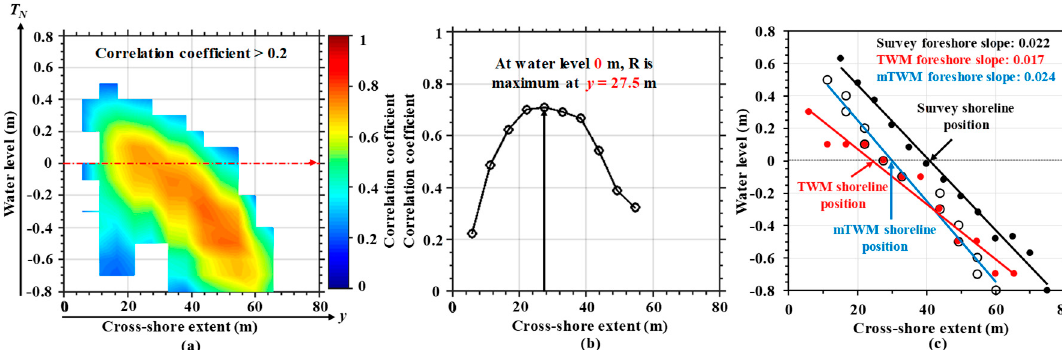
Figure 10. An example of a modified Temporal Waterline Method (mTWM) detected intertidal beach profile at x = − 49 m during 17–30 June 2005. ( a ) The distribution of correlation coefficients for different tidal signals ( − 0.8 to 0.8 m) and cross-shore positions ( 0 ≤ y ≤ 80 m ) . ( b ) The distribution of correlation coefficients for cross-shore positions at water level 0.0 m. The maximum correlation is established at y = 27.5 m. ( c ) The intertidal beach profile determined by linear regression. The shoreline position ( y = 30 m) is defined at water level 0.0 m, where red and black regression lines indicate the TWM and survey intertidal beach profile, respectively, on 17 June 2005.